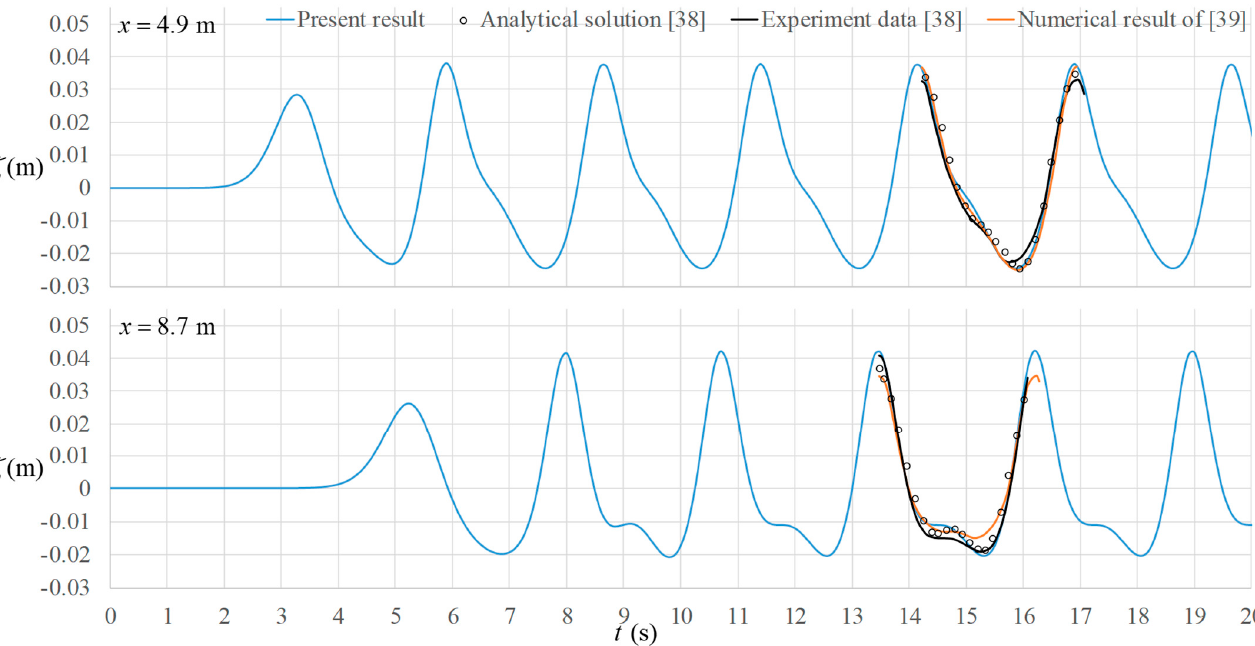
Figure 5. Comparison of the present numerical results with the other data (experiment data [38], analytic solution [38], and the numerical results of [39]) at wave gauges for the case of nonlinear waves generated by a large stroke harmonic motion of a piston type wave maker.